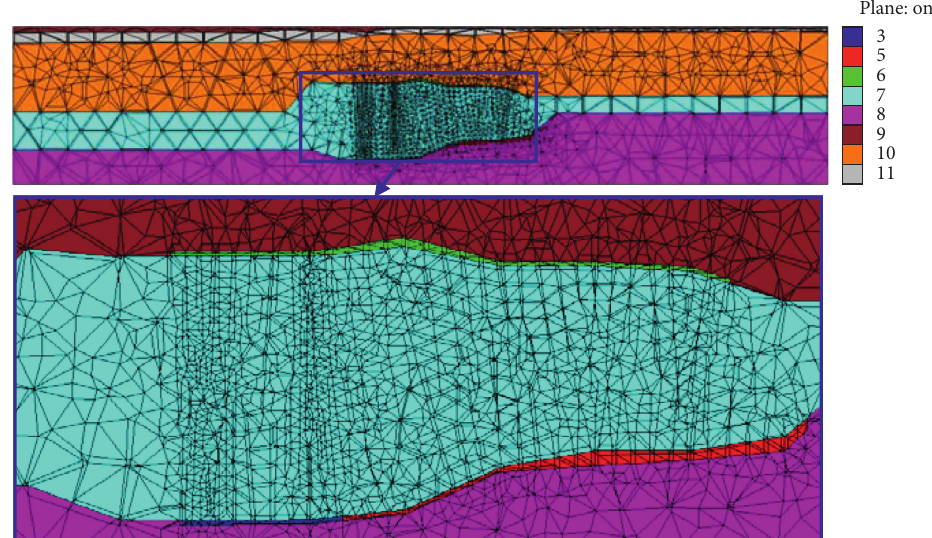
Figure 8: Unit diagram of the calculation model (note: group 9 is quaternary; group 11 is Neogene; group 10 is K1 roof rock; group 7 is K1 floor rock and K2 roof rock; group 8 is K2 floor rock; group 3, group 5, and group 6 are ore bodies.).